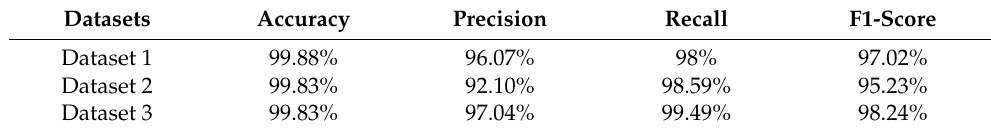
Table 5. Performance matrix results of all